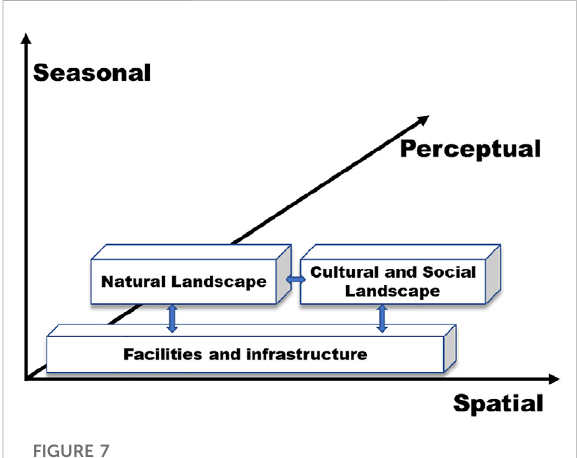
FIGURE 7 The interrelationship of landscape characters in rural